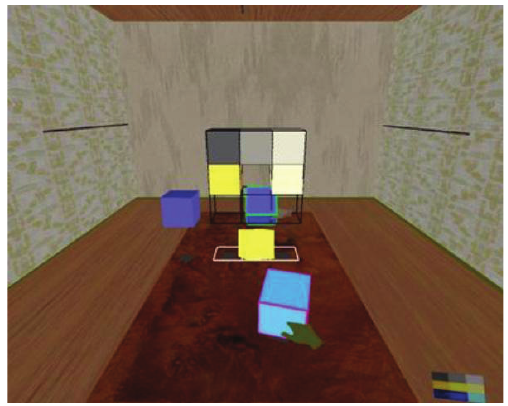
Figure 3: Screenshot of ray-casting metaphor.